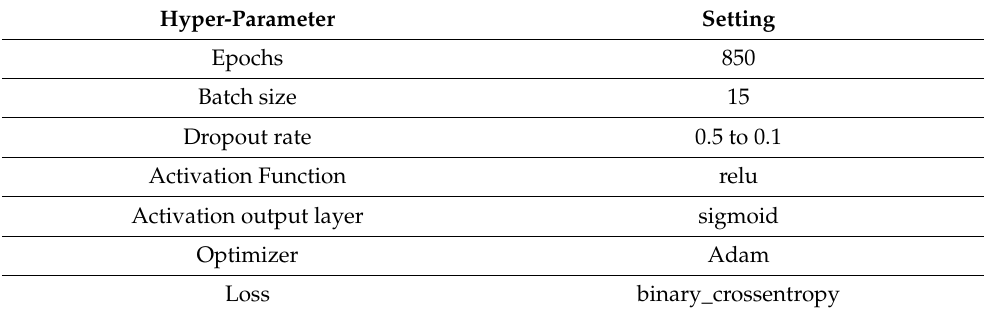
Table 4. Hyper-parameter